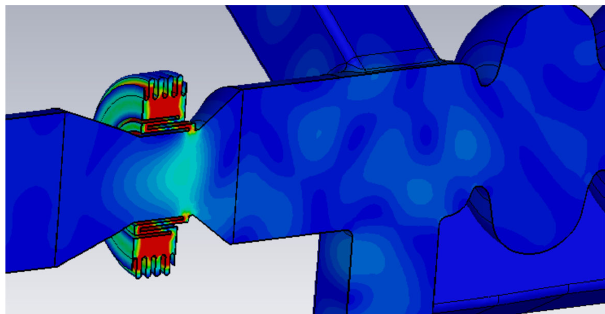
FIG. 4. (Unscaled) E-field power density of the third mode, found at 3.923 GHz, which extends into the